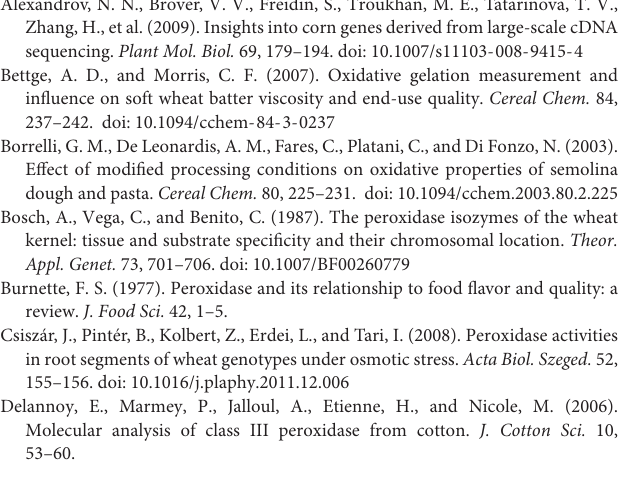
Figueroa-Espinoza, M. C., Morel, M. H., Surget, A., and Rouau, X. (1999). Oxidative cross-linking of wheat arabinoxylans by manganese